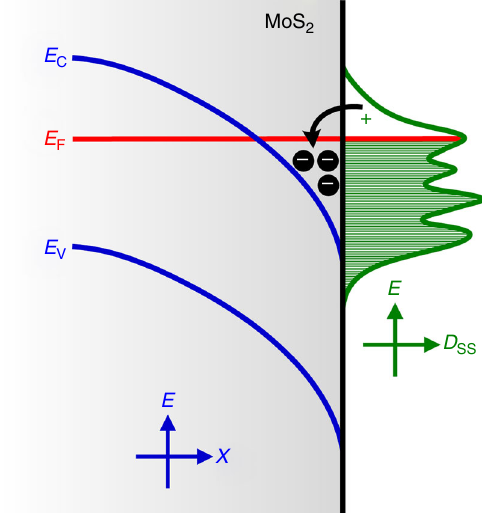
Fig. 10 Schematic band bending and electron accumulation at a MoS 2 surface. A schematic band diagram of the surface of MoS 2 . The surface band bending and surface electron accumulation (SEA) induced by the presence of donor-like surface states are illustrated. The surface state density ( D ss ) distribution is plotted schematically to present the Fermi-level pinning by surface states